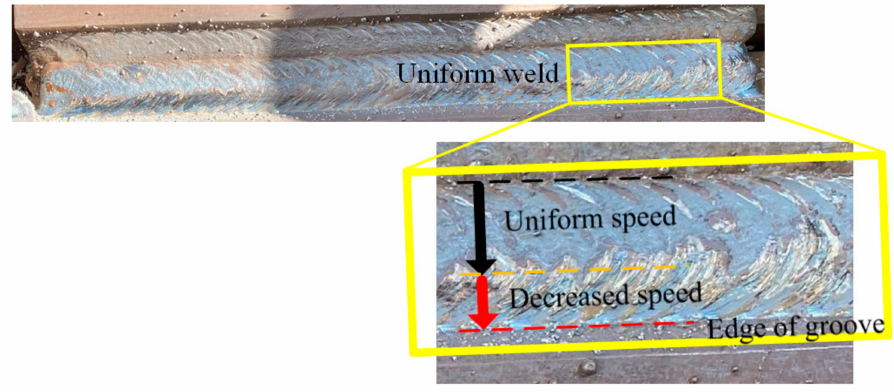
Figure 15. Selected weld and the partial features of the experimental